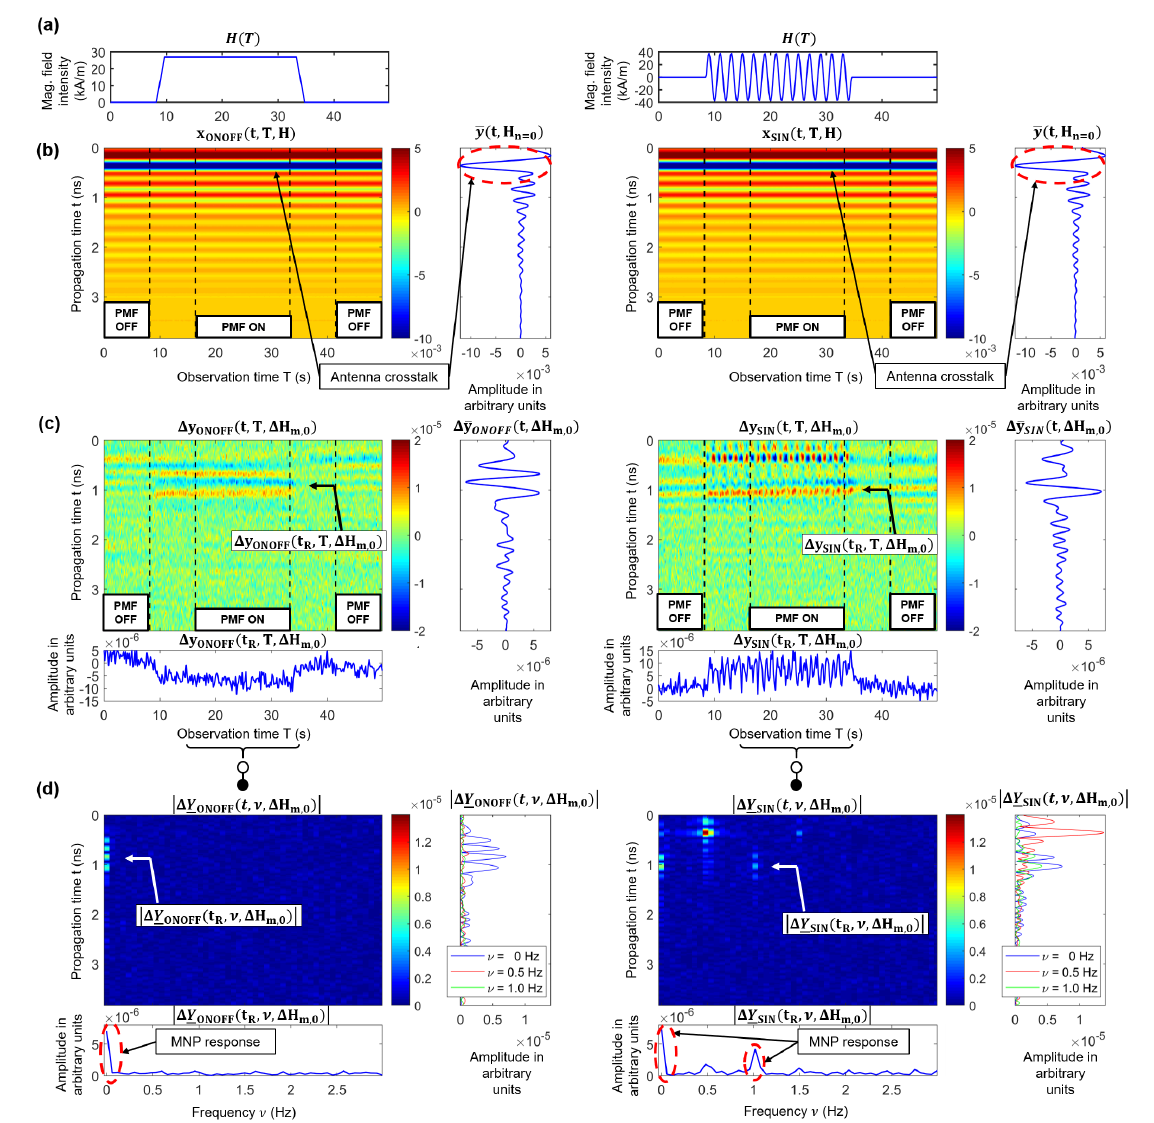
Figure 4. Exemplary signal processing and clutter removal for the ON/OFF modulation (left column) and the SIN modulation (right column): ( a ) Magnetic field intensity depending on the measurement time at the position of the MNPs. ( b ) Raw radargram y MOD ( t , T , H ) and the estimated clutter signal y ( t , H n = 0 ) averaged over the time period without the presence of the external PMF. ( c ) Clutter removed radargram ∆ y MOD ( t , T , ∆ H m ,0 ) with the mean MNP response ∆ y ( t , ∆ H ) averaged over the time period with the presence of the external PMF. ( d ) Single-sided magnitude spectrum m ,0 MOD | ∆ Y ( t , ν , ∆ H ) | . The index t m ,0 R represents the propagation time corresponding to the expected MNP MOD